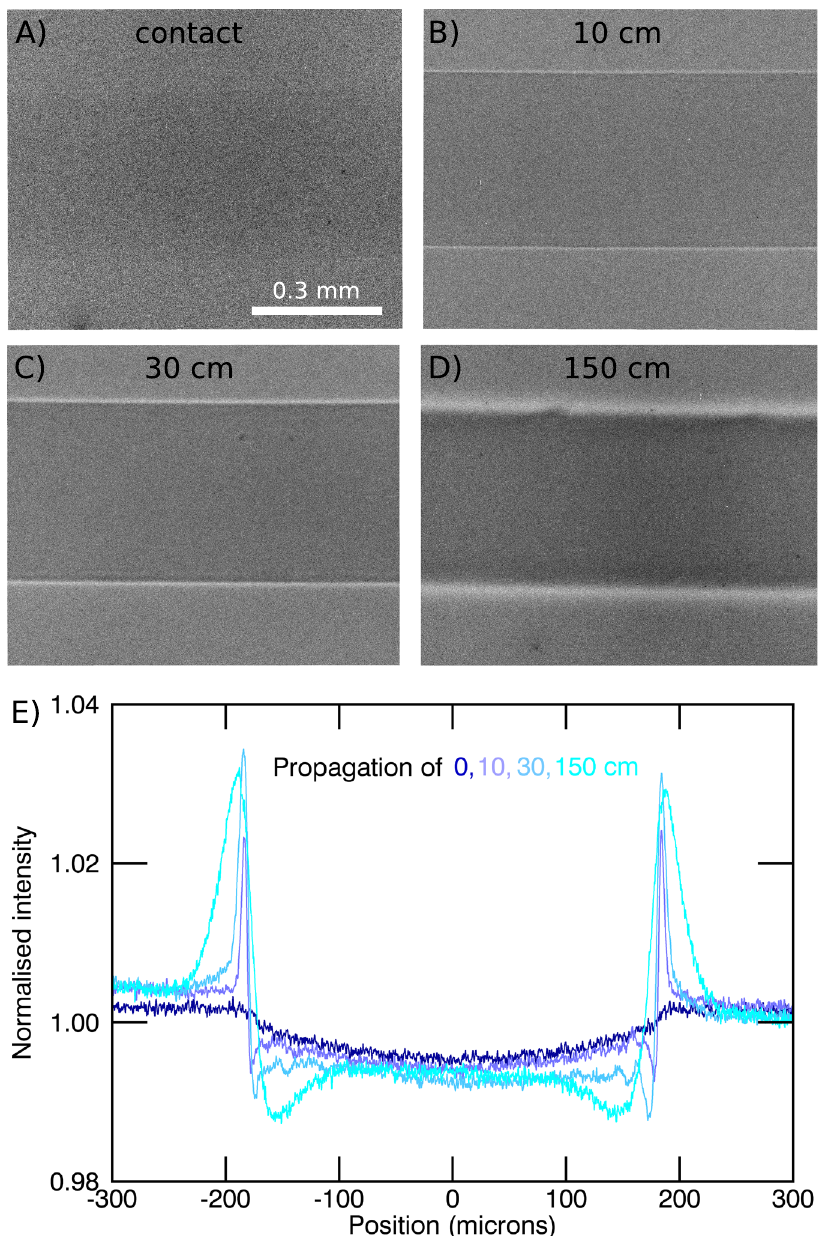
Figure 2. Nylon fiber (350 μ m diameter) imaged with a detector pixel size of 0.65 μ m for different propagation distances. ( A ) In the contact regime the contrast of the fiber is very weak. In the propagation range between ( B ) and ( C ) the edge-enhancement delivers contrast to better visualise the fiber. ( D ) Due to the source-blurring the edges are smeared out for large distances, but the increased width at this distance means the edge-enhancement can be detected with larger pixels. ( E ) Intensity profiles across the images in ( A–D ) (exposure time = 240